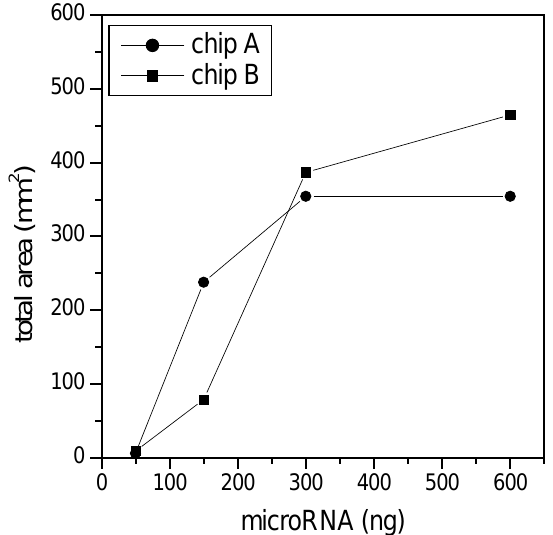
Figure 7. Testing microdevices performances in miRNAs adsorption. The adsorption of different quantities of synthetic fluorescent microRNA (miR-1246-TAMRA) dissolved in water on the two types of chips is measured as the total spiral length occupied by microRNA after washes.